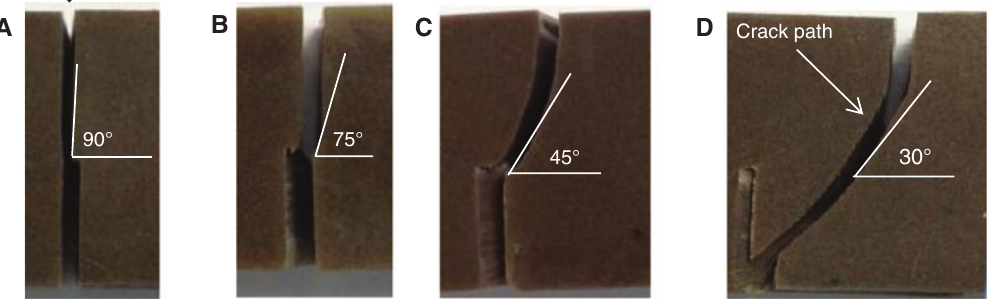
Figure 6: Crack kink angles of SENB specimens at SSA content of 5 wt% for: (A) mode I θ = 90 ° , (B) mixed-mode θ = 75 ° , (C) mixed-mode θ = 45 ° , (D) mixed-mode θ = 30 °